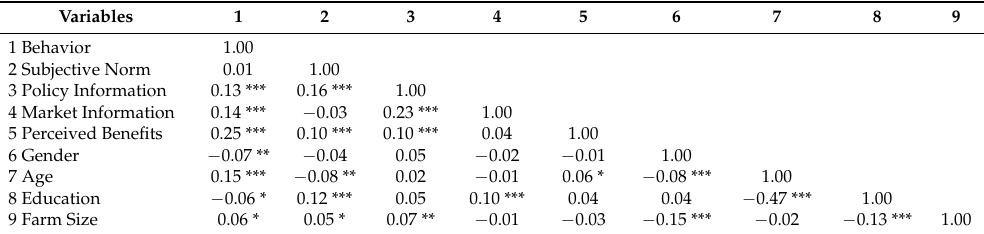
Table 4. Spearman rank correlation coefficients among the variables (n =